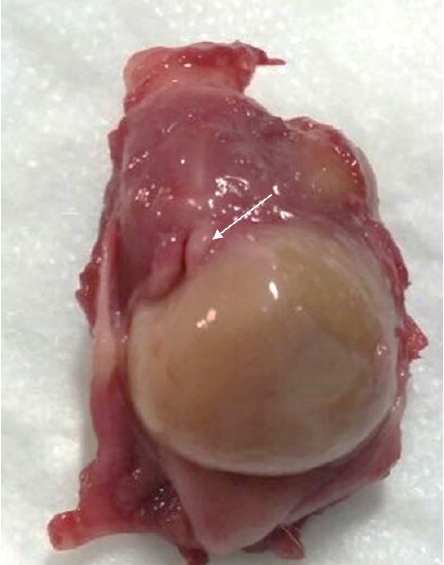
Figura 5. Fragmento de laringe, durante procedimento de necropsia, evidenciando massa de grandes dimensões causando compressão (seta) das cartilagens aritenóides.